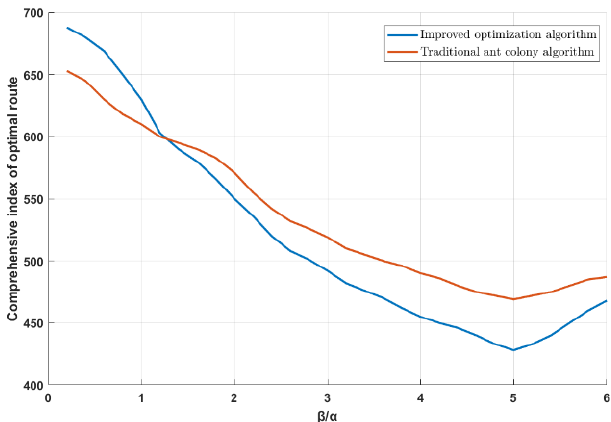
Figure 10. Path evaluation